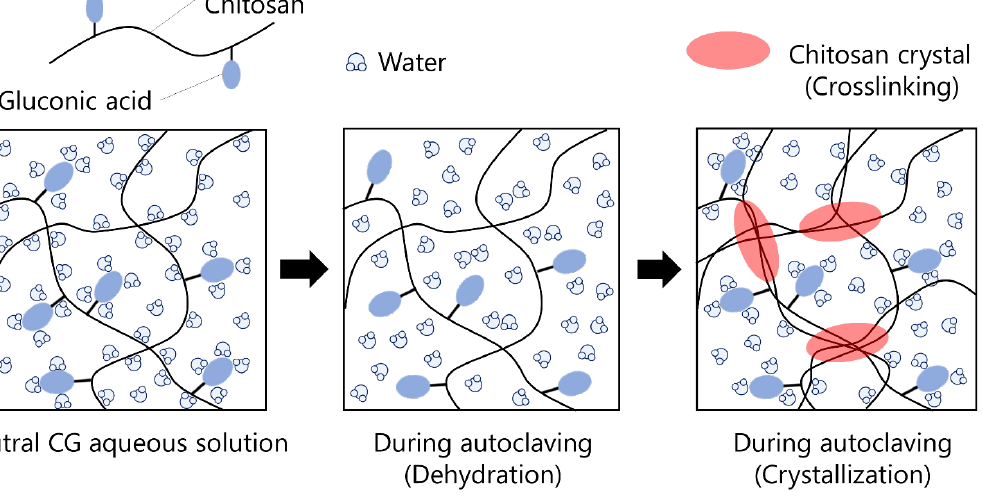
Scheme 2. Mechanism of hydrogelation of chitosan-gluconic acid conjugate (CG) aqueous solution